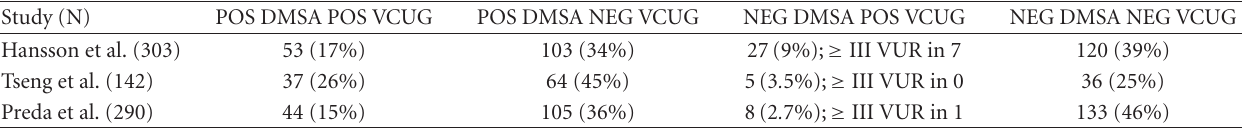
Table 1: Results of studies analyzing concordance between DMSA and VCUG